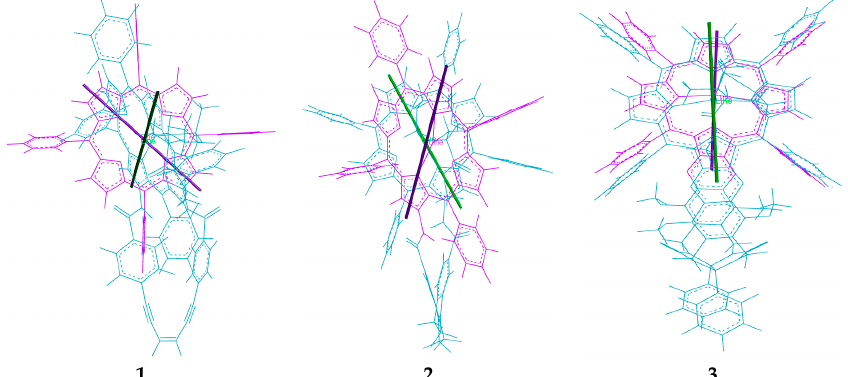
Figure 13. Alignment of porphyrin axes in the complexes with chiral guest lysine methylester 23 . Line positions are indicated for 23 with tweezers 1 , 2 and 3 , respectively.